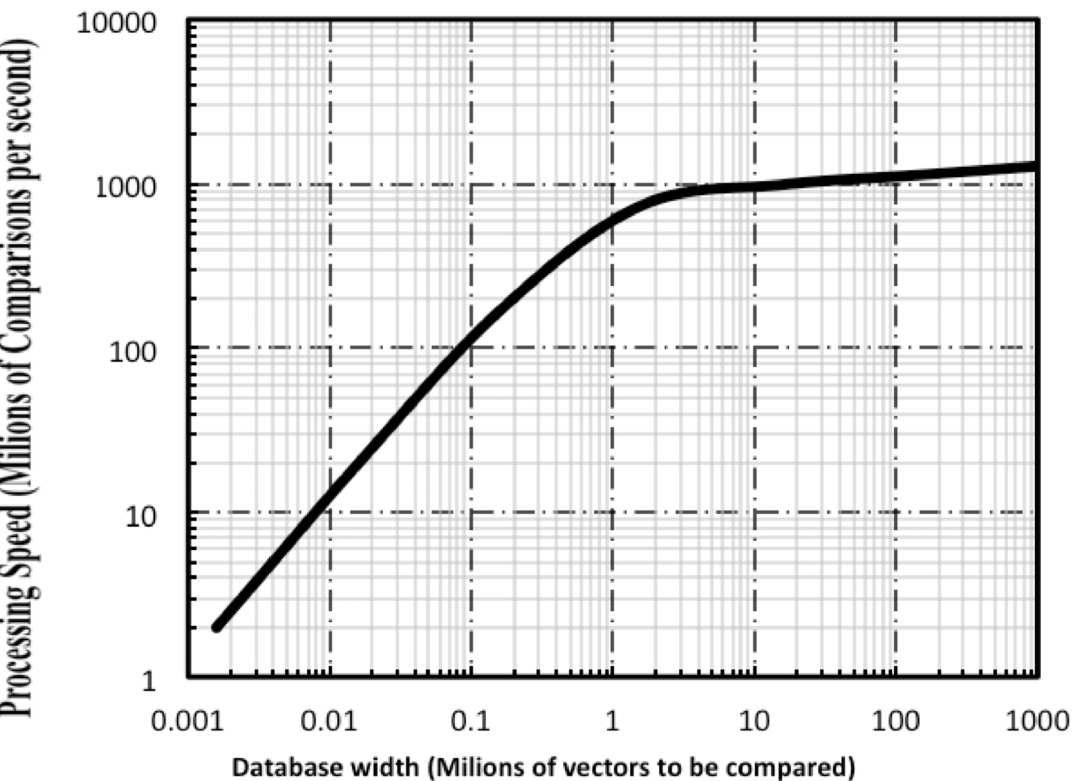
Fig 15. Data mining speed variation with database width when using probabilistic computing. Each comparison implies the processing of two vectors of 12 Bytes each